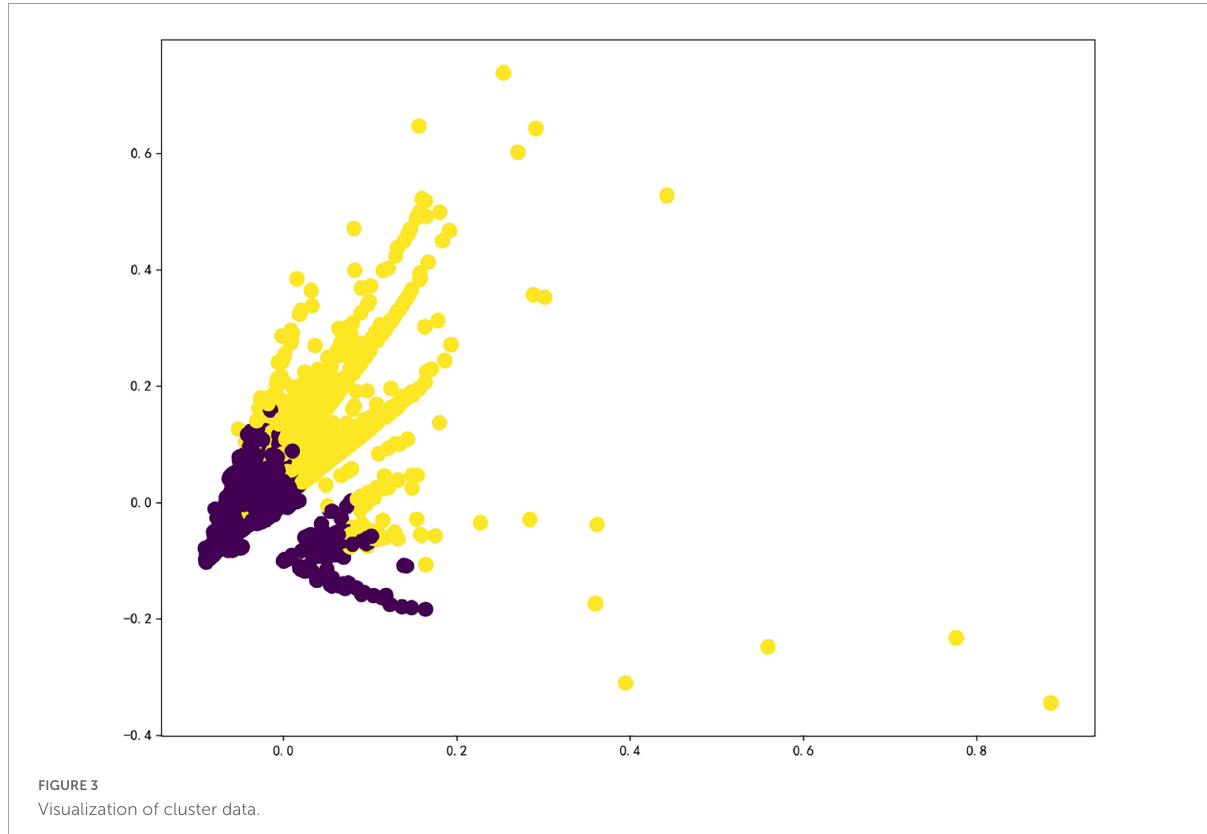
FIGURE3 Visualization of cluster